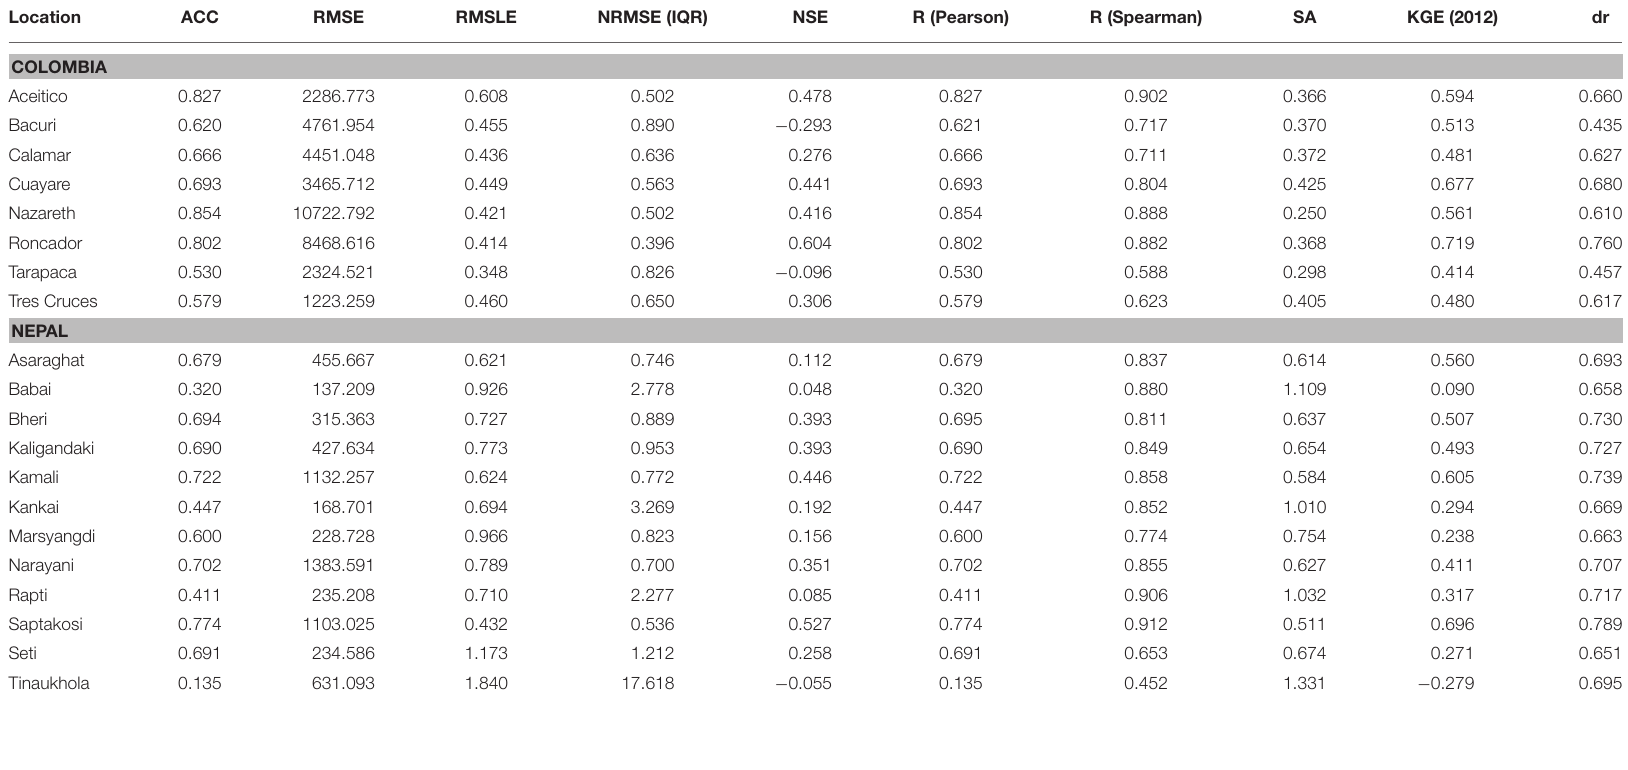
TABLE 3 | Error metrics for Colombia and Nepal ( Data sheet 1 has the charts for Colombia and Data Sheet 2 the charts for Nepal).